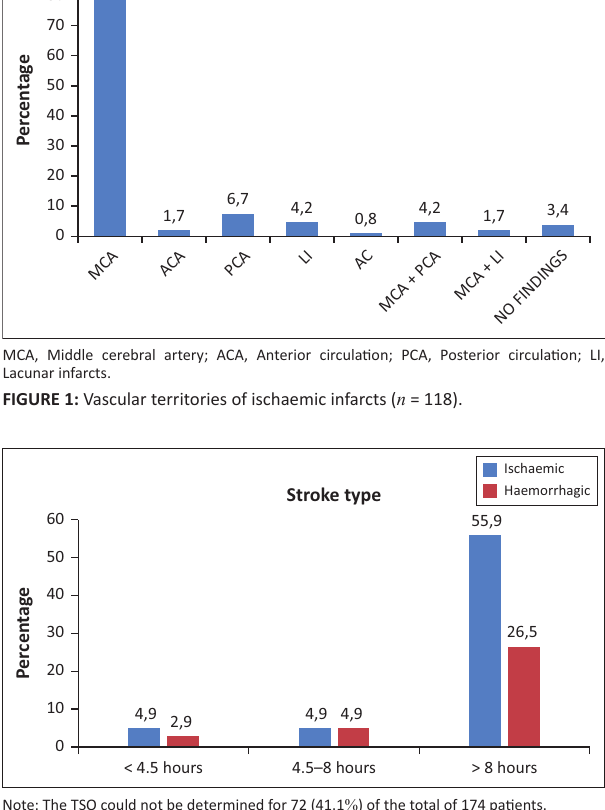
FIGURE 2: Stroke type versus time from symptom onset (TSO). Graphic illustration of the 102 patients with ischaemic infarcts and known TSO.